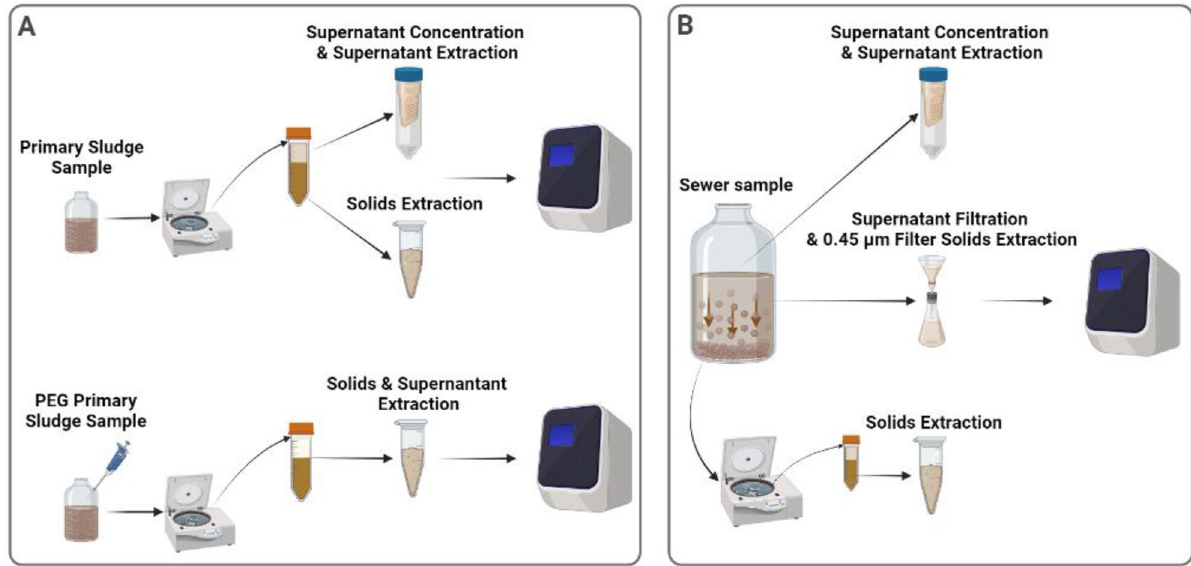
Figure 4. Process flowchart describing: ( A ) Processing of primary clarified sludge samples to examine the fractionation of influenza A viral signal within the supernatant and solid pellet with and without PEG addition, and ( B ) Processing of municipal wastewater to examine the fractionation of influenza A viral signal within the supernatant, filtered suspended solids and solid